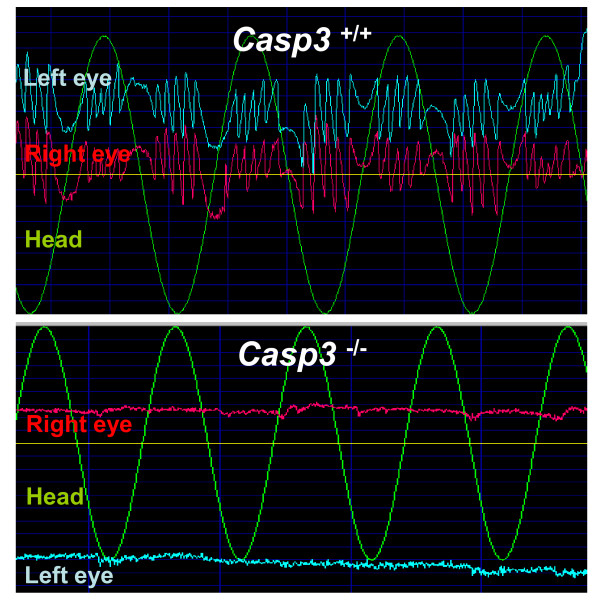
Caspase-3 deficient mice have vestibular dysfunction. Representative raw tracings of head velocity (green line), left horizontal eye movement (light blue line), and right horizontal eye movement (red line) at 0.2 Hz, 90°/sec sinusoidal rotation. Casp3-/- mice (lower panel) showed no ocular response to the stimulus, whereas Casp3+/+ mice (upper panel) showed robust response.